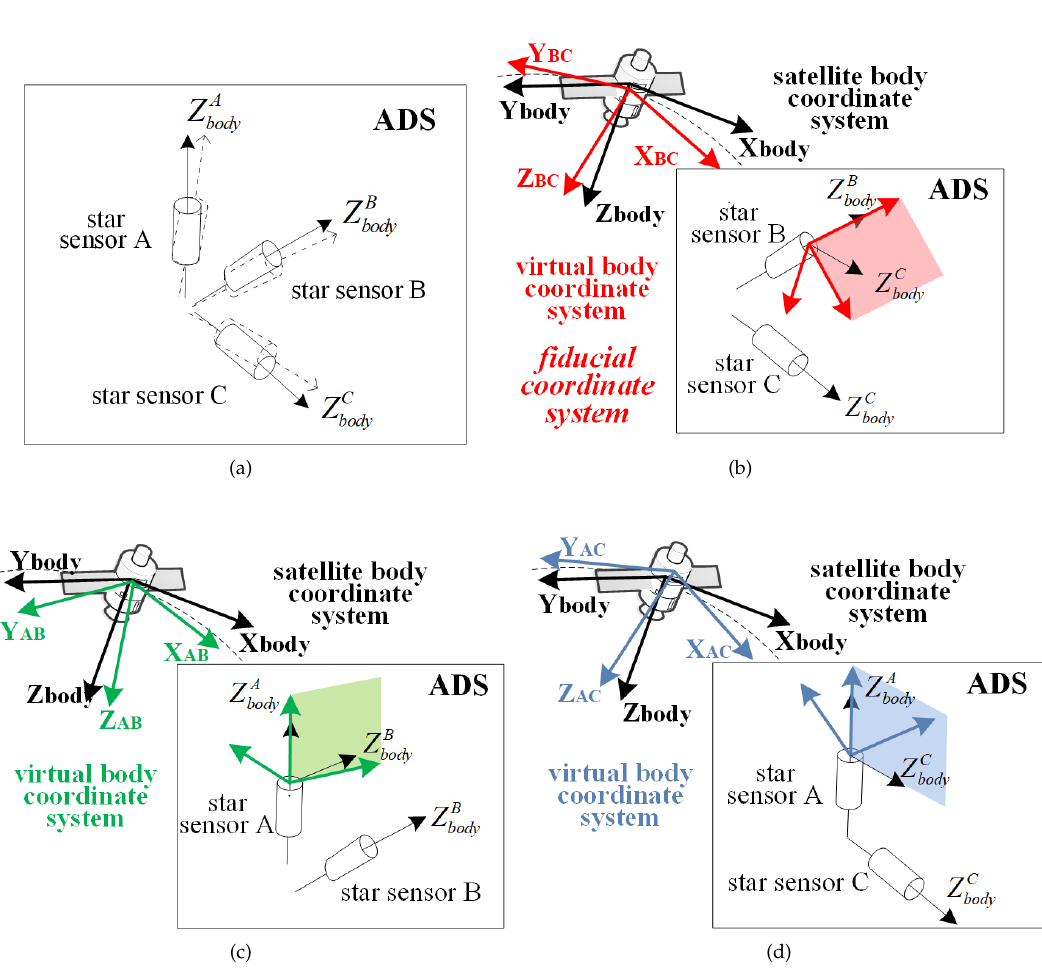
Figure 3. The diagram of installation error of star sensor and the virtual body coordinate system. ( a ) on-orbit installation error of star sensor, ( b ) the virtual body coordinate system formed by the on-ground installation parameter of star sensors B and C, ( c ) the virtual body coordinate system formed by the on-ground installation parameter of star sensors A and B and ( d ) the virtual body coordinate system formed by the on-ground installation parameter of star sensors A and